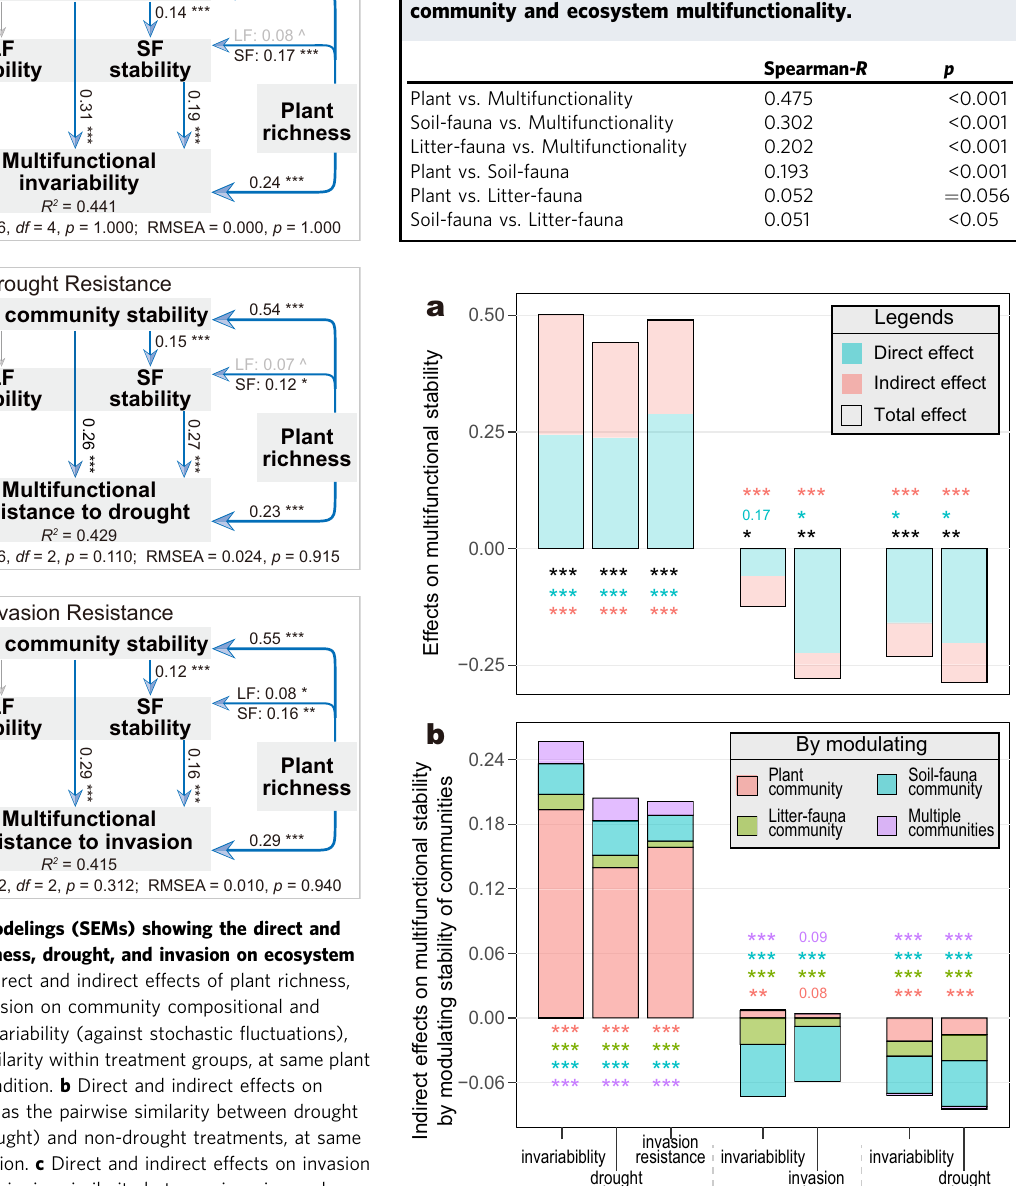
Table 2 Mantel test showed the positive relationships among communities, and the signi fi cant links between community and ecosystem multifunctionality.